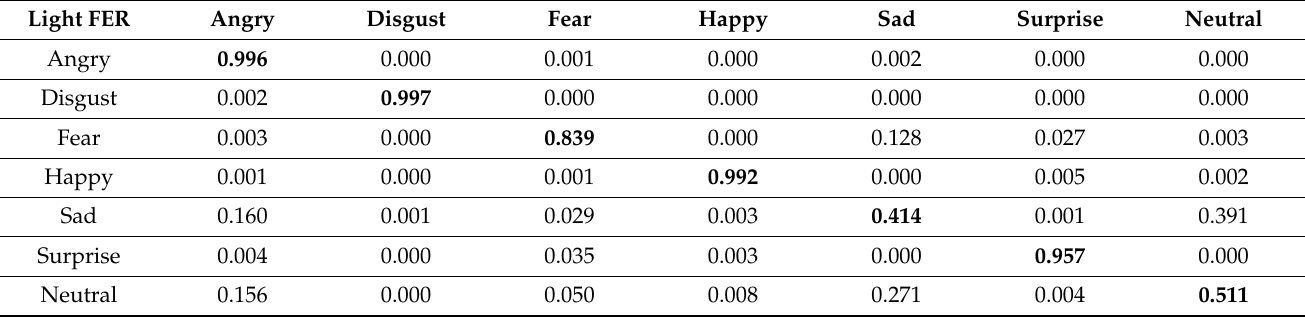
Table 1. Actual test results of the proposed